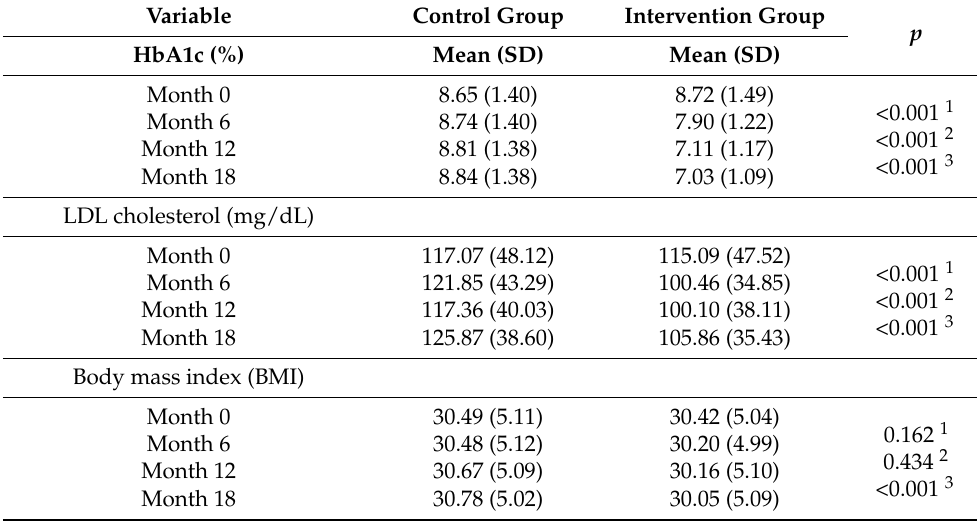
Table 2. Evolution of primary and secondary metabolic outcomes in the control and intervention groups during the RCT 18-months